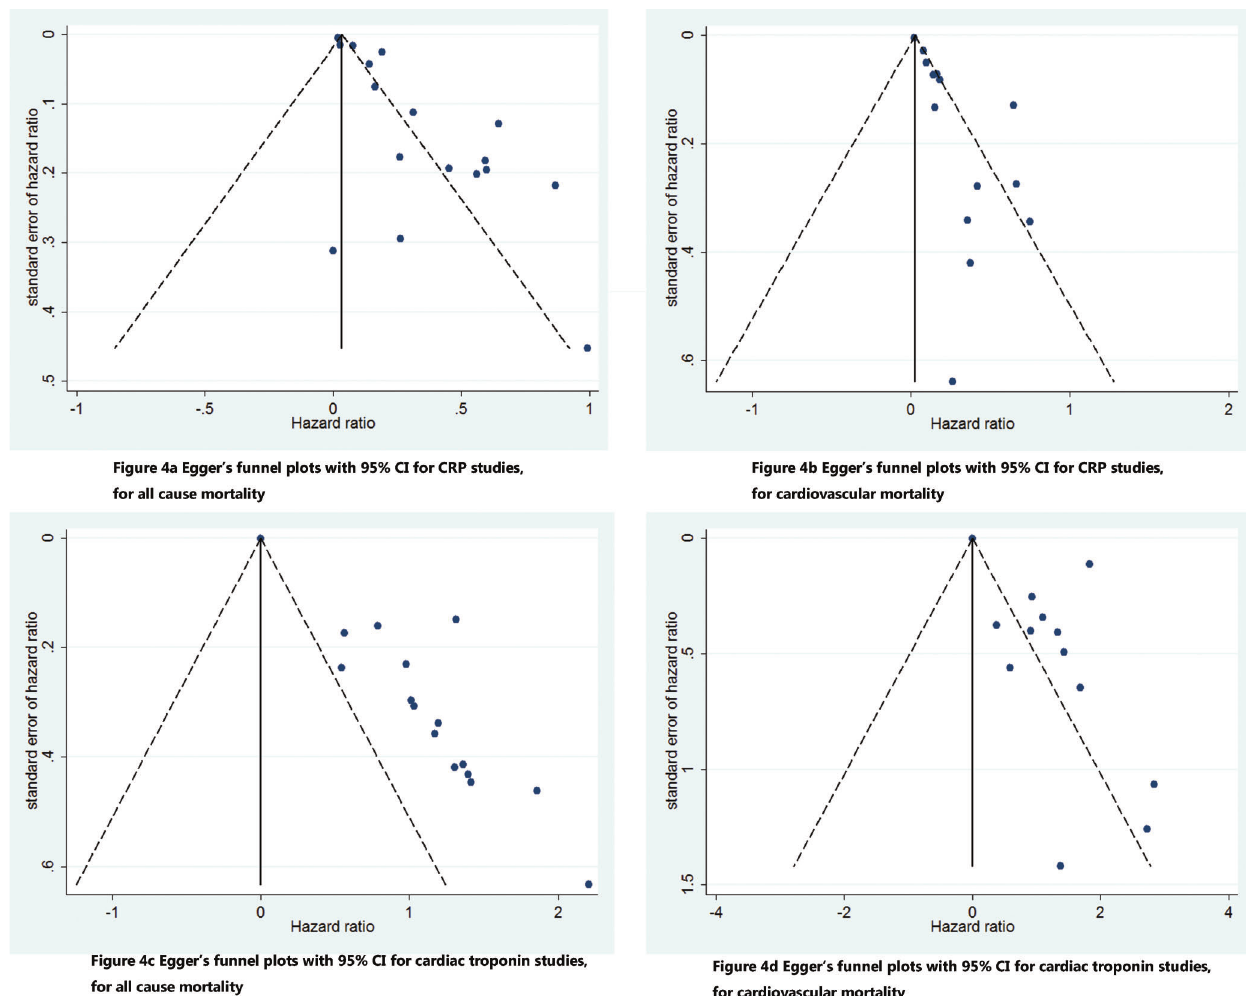
Figure 4 - Egger’s funnel plots for C-reactive protein and cardiac troponin studies. Publication bias was found in this meta-analysis. CRP, C-reactive protein; CI confidence